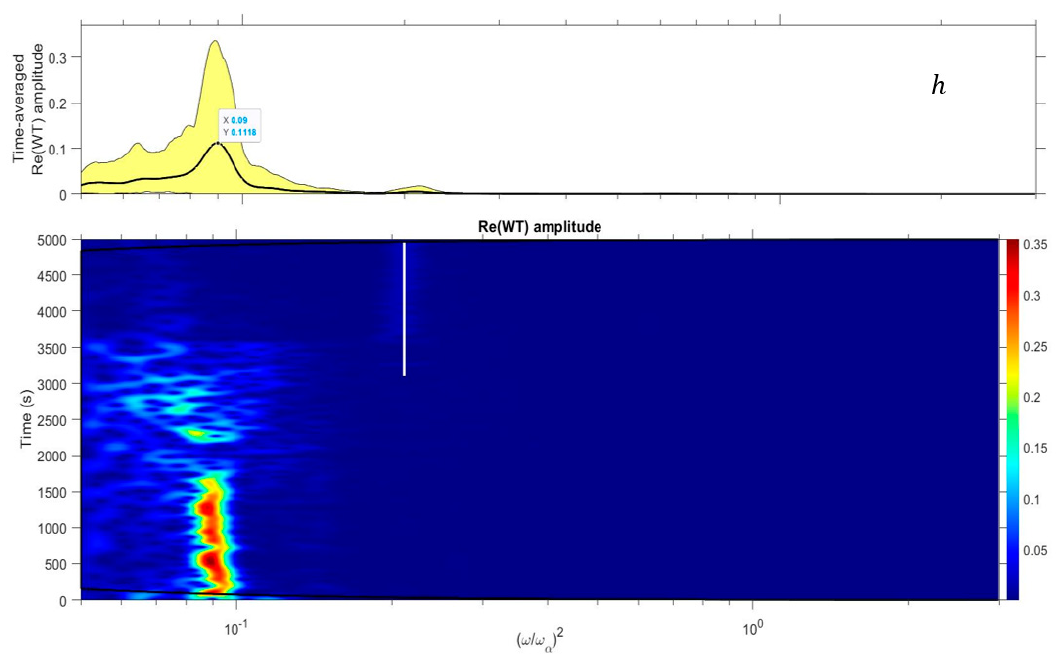
Figure 8. Time–frequency analysis of plunge/bending displacement signal ( 𝑄 (cid:3042) = 9 ).